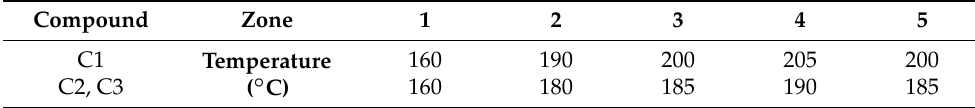
Table 2. Temperature zones in the single screw extruder during filament extrusion.